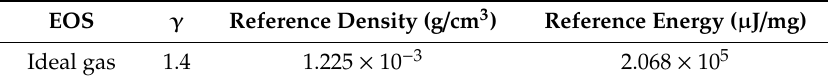
Table 2. Ansys / Autodyn material model for the air. EOS γ Reference Density (g / cm 3 )